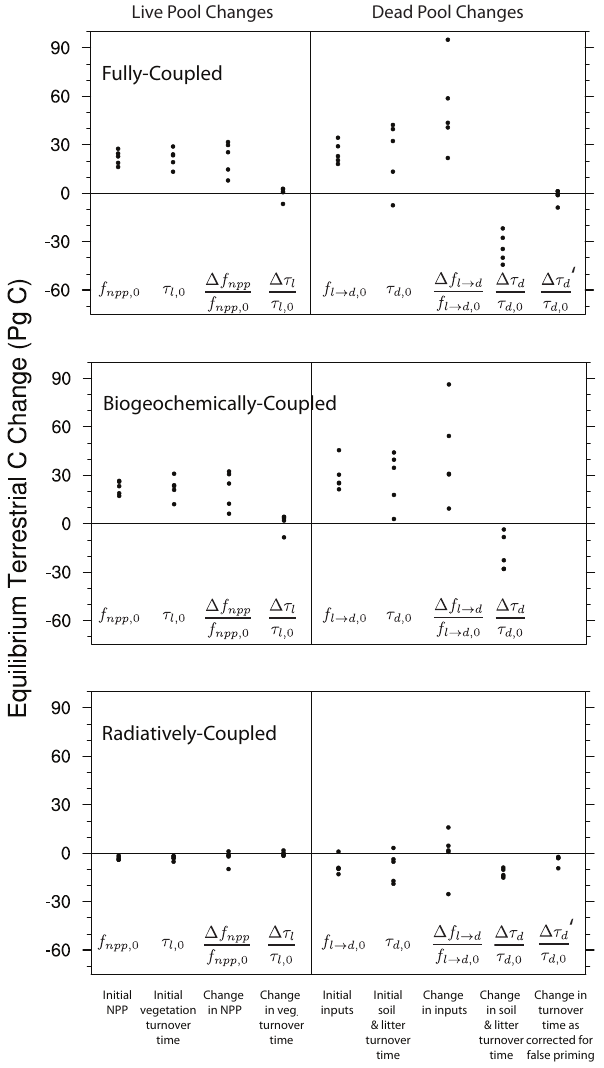
Figure 14. Inter-model uncertainty in total integrated linearized equilibrium carbon responses resulting from each of the driving terms. The left four columns are the terms that drive live carbon changes (from left to right): initial productivity, initial turnover times, fractional change in productivity, and fractional change in turnover times. The right four columns are the corresponding con- trols on dead carbon (from left to right): initial productivity, ini- tial turnover times, fractional change in productivity, and fractional change in turnover times. For each term, the relevant linearized equilibrium carbon stock changes were calculated using the indi- vidual model values for that term, and multi-model ensemble-mean values for all of the other terms, so the model spread reflects the uncertainty in the response to just that